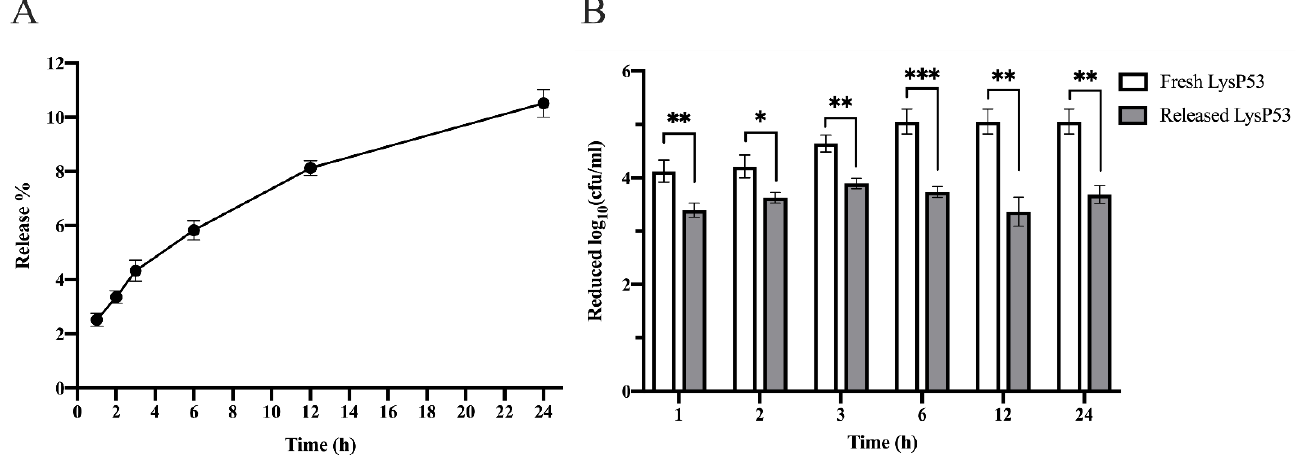
Figure 3. Analysis of LysP53 release rate, activity, and stability after release from LysP53 hydrogels at different times. ( A ) The cumulative release rates of LysP53 from the LysP55 hydrogel at different times. ( B ) Comparison of the activity of LysP53 hydrogel and freshly prepared LysP53. Freshly pre-